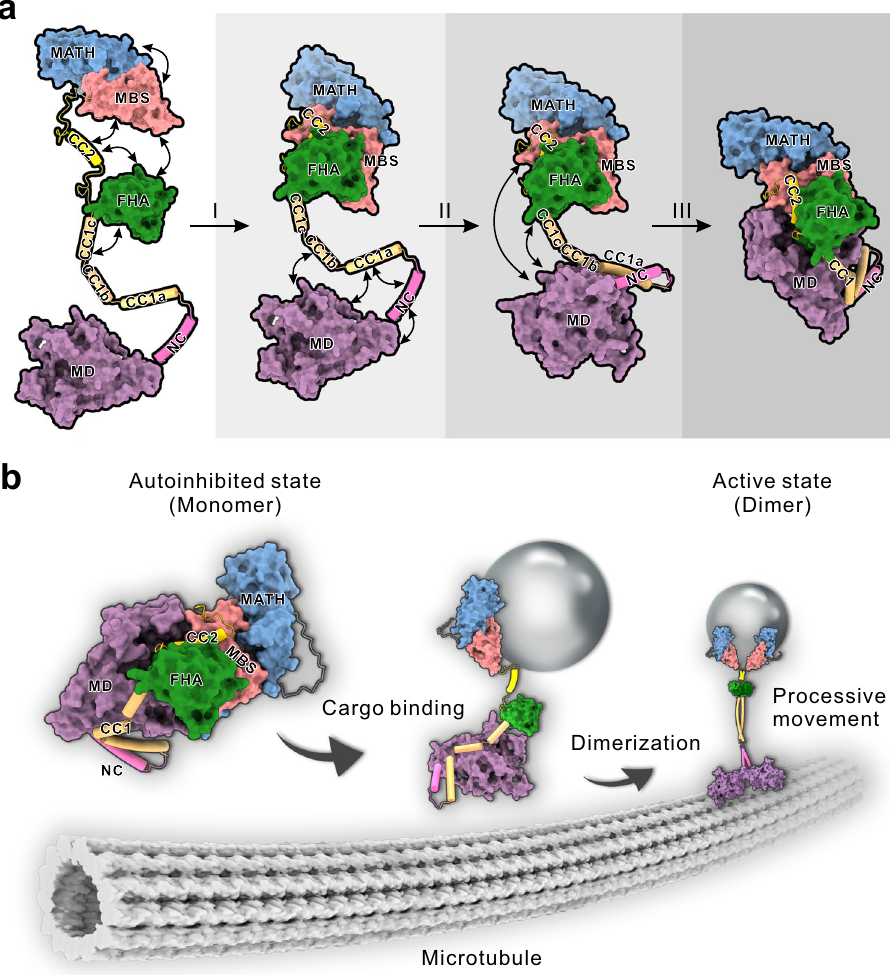
Fig. 5 | Working models for the multilevel autoinhibition and the cargo- mediated activation of kinesin-3 KLP-6. a A working model for the cooperative self-folding process of full-length KLP-6 for autoinhibition with multiple levels. In level I, CC2 associates with the FHA and MBS domains and cooperates with CC1c andtheMATHdomaintoformtheCFCMMsupramodule;inlevelII,CC1(CC1aand CC1b) folds back to pack with the NC and MD to restrain the neck domain; and in level III, the CFCMM supramodule folds back to associate with the MD to form a compact self-folded motor. In this model, the MD and the FHA, MBS and MATH domains are in the surface representation, and the NC, CC1, and CC2 are in the ribbon representation. b A schematic working model for the cargo-mediated